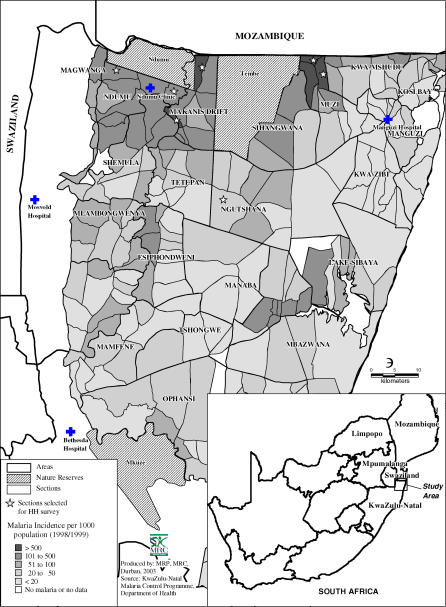
Map of Umkhanyakude District, Northern KwaZulu–Natal, South AfricaThe map indicates the following: the malaria risk by section and the four sentinel facilities for malaria morbidity and mortality review (Ndumo clinic, and Mosvold, Manguzi, and Bethesda rural district hospitals); the communities selected for the household (HH) survey and FGDs; and the Manguzi district hospital where sentinel safety surveillance and Ndumo Clinic where the SP (2000) and AL (2002) in vivo therapeutic efficacy studies were conducted.